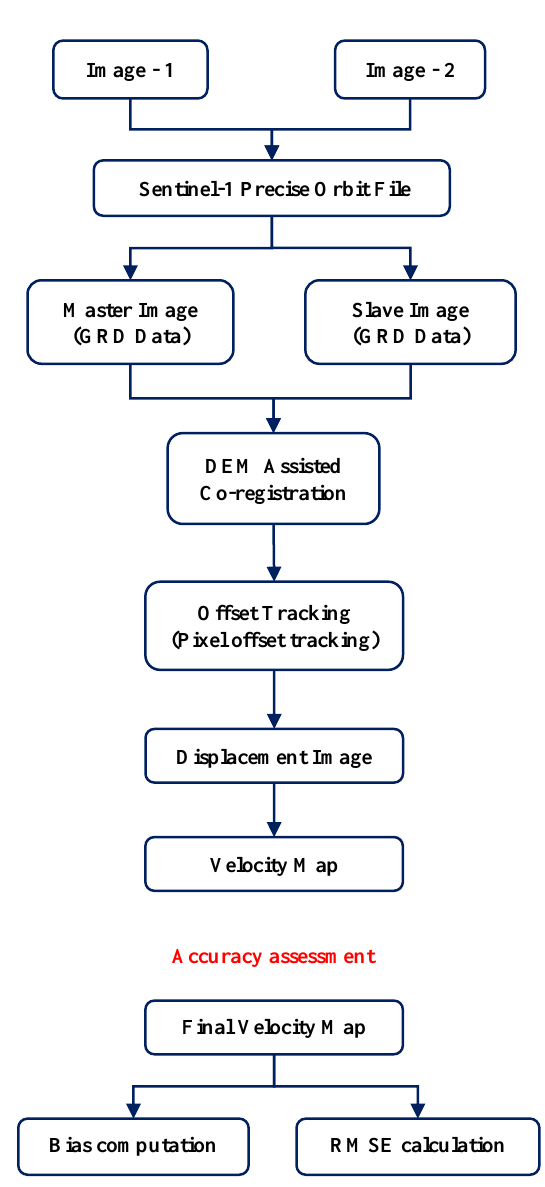
Figure 3. Flowchart of methodology adopted for the